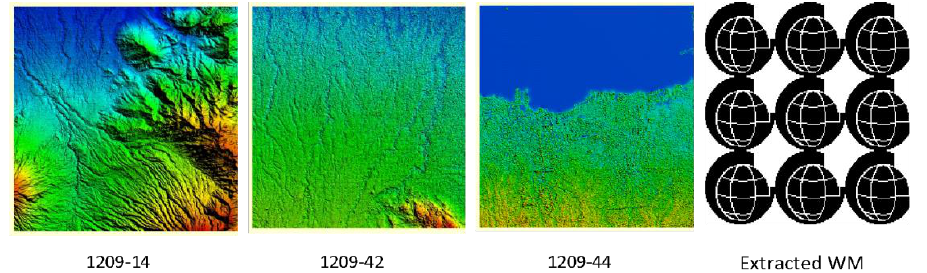
Figure 12. Watermarking results using the 2D DCT algorithm; 100% watermark image extracted with 2D DCT applies equally to all image areas. Figure 13. Results of watermarking using a combination of 2D DWT and 2D DCT algorithms; 100% watermark image extraction was realized with 2D DWT and 2D DCT. However, this extraction is not superior to that of DCT only because the distortion to the elevation value is quite large; thus, some extractions reaching 1160 m apply equally to all image areas. Figure 14. Results of watermarking using the 2D DFT algorithm. The best watermark image that can be extracted with DFT is 94.21%, which is applied on the DEMNAS 1209-44. 6. Conclusions